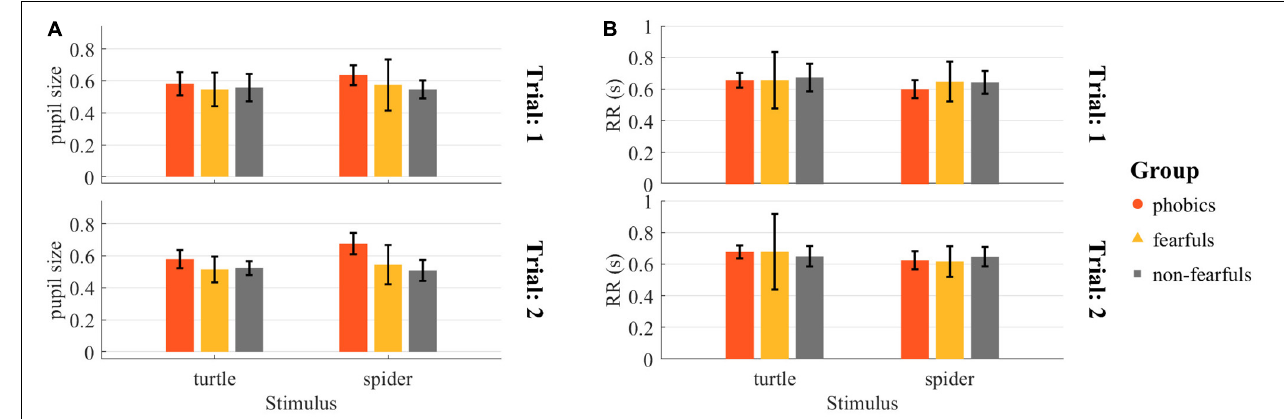
FIGURE 10 | Physiological readouts during the Touch the Enemy task: (A) Mean rescaled pupil size during the last 0.5 s before the touch of the stimulus. The rmANOVA revealed a significant group × stimulus interaction. (B) Mean RR interval during the last second before the touch of the stimulus. The rmANOVA revealed no significant effects or interactions (all p > 0.05). RR interval = heartbeat to heartbeat